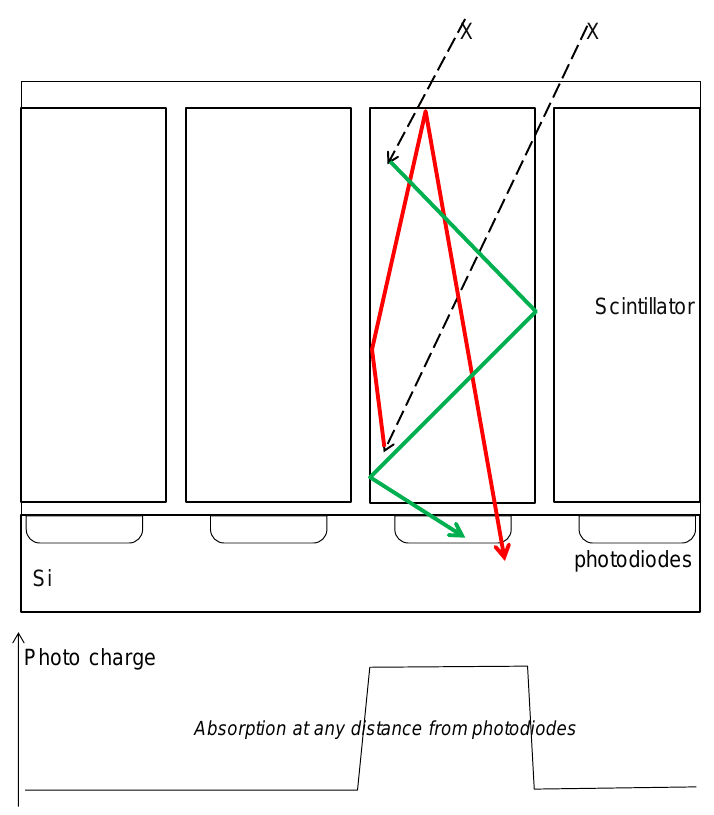
Figure 15. Similar drawing as Figure 14, now with optically confined scintillators on top of the silicon pixels.